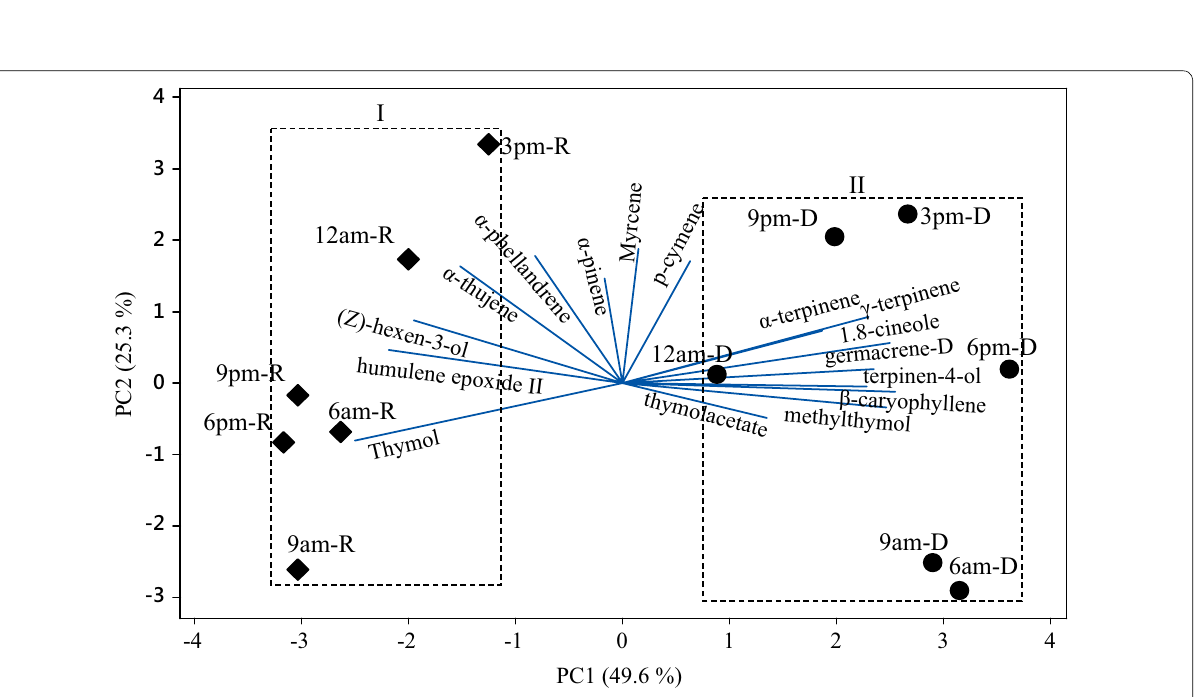
Fig. 4 Biplot (PCA) resulting from the analysis of the oil constituents of L. thymoides in the circadian study, during the rainy (R, February) and dry (D, September)